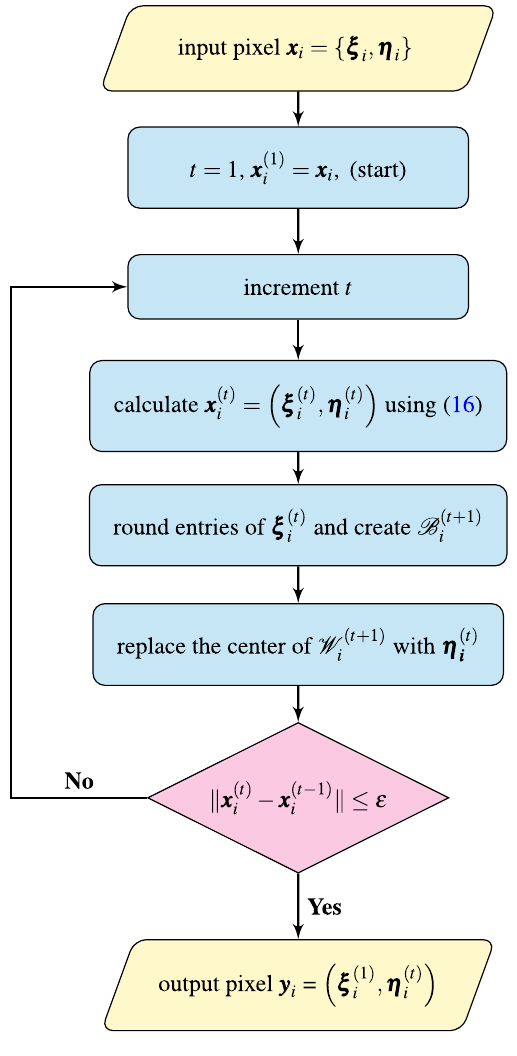
, η ( t ) = ( ξ ( t ) ) stands for the result of t iterations, (pixel at position ξ ( t ) i i i block and filtering window centered at ξ stopping criterion.